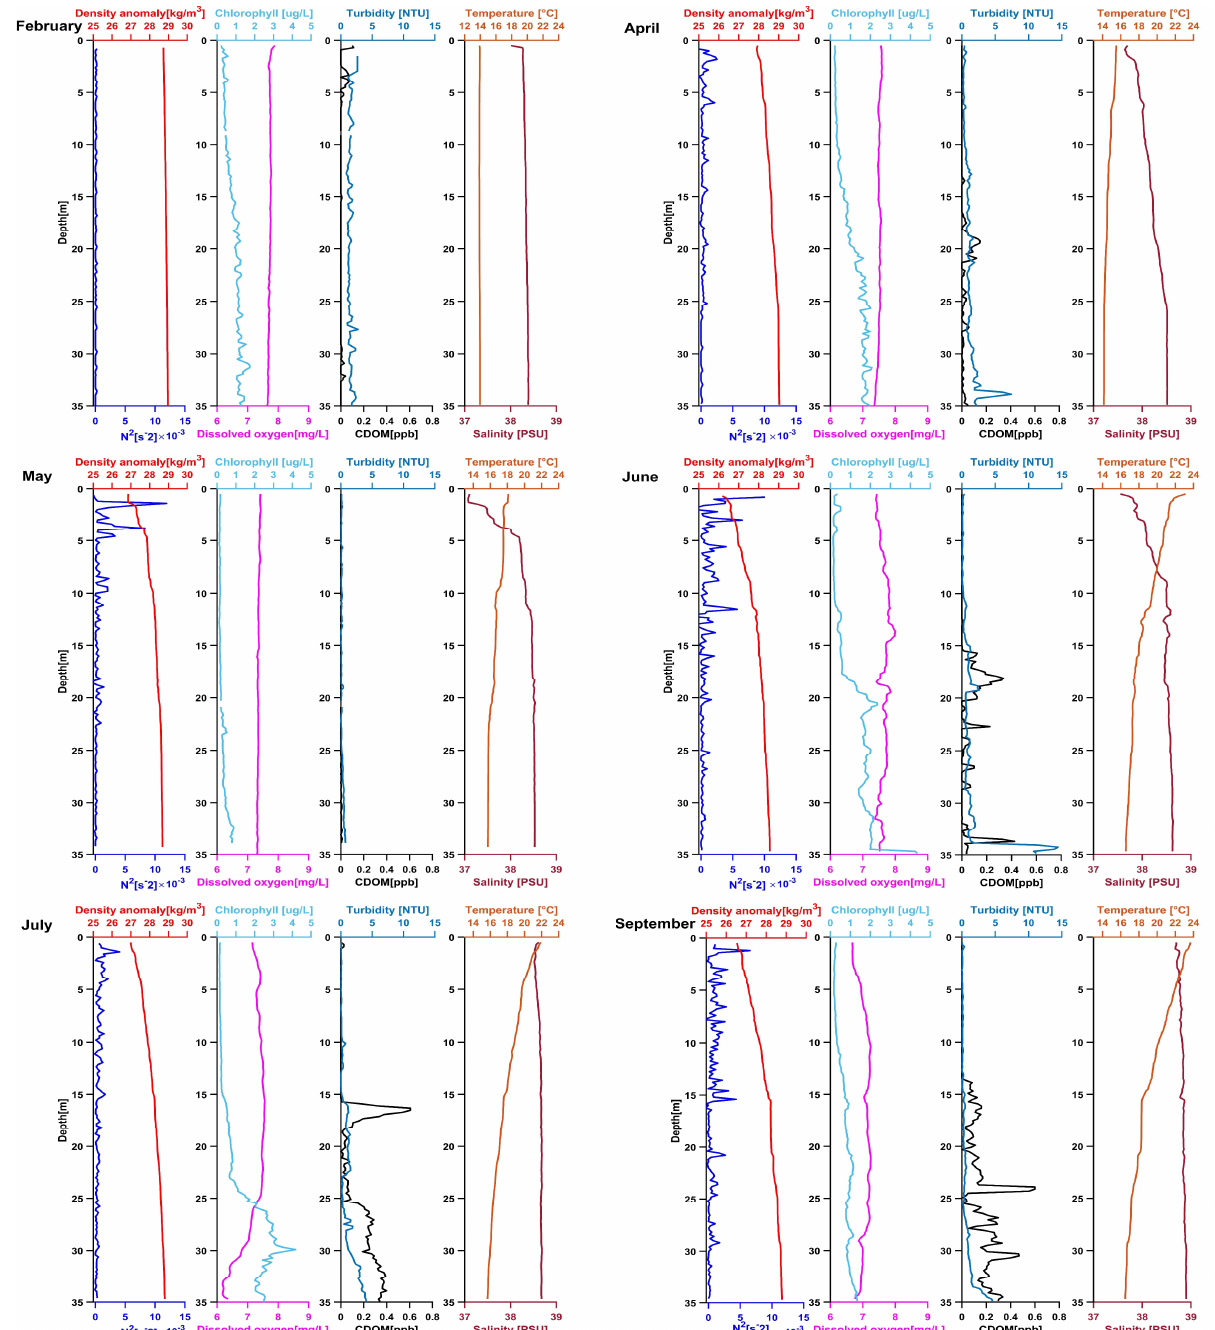
Figure 3. Vertical profiles sampled during 2020 at location 2. The measured parameters are density anomaly (red line), buoyancy frequency (blue line), chlorophyll (light blue line), dissolved oxygen (magenta line), turbidity (green line), CDOM (black line), temperature (orange line), and salinity (brown line).